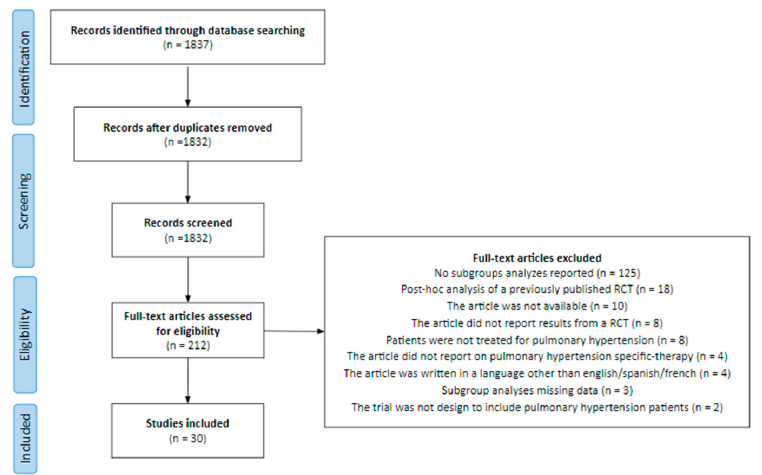
Figure 1. Flowchart of the screening of randomized clinical trials included in this analysis.